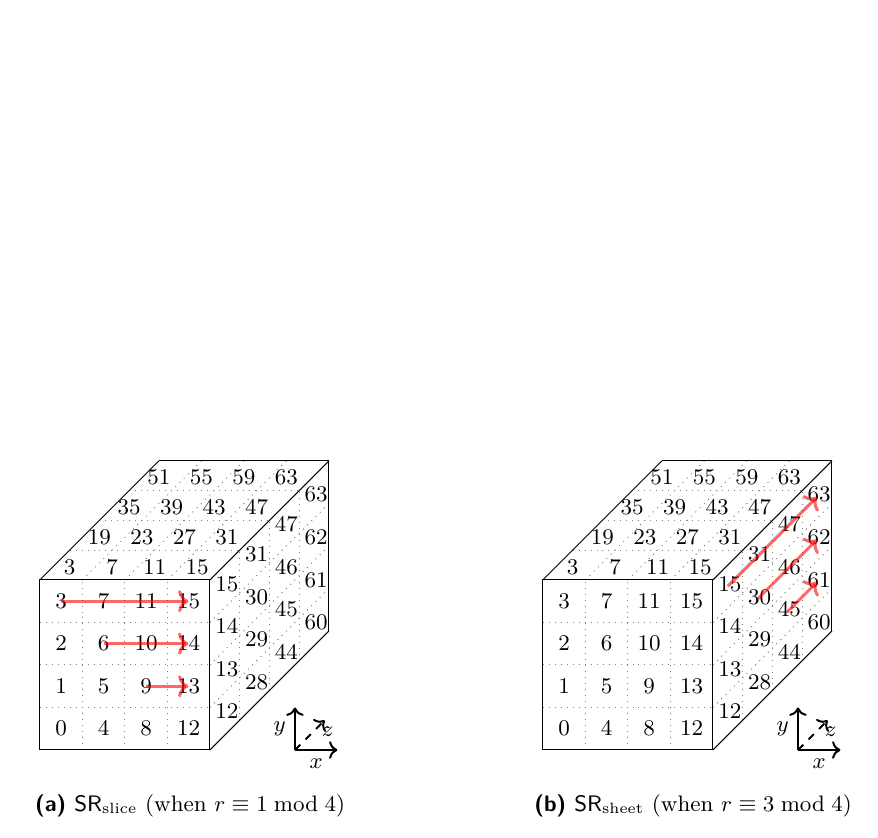
Figure 5: Representation of the SR 𝑟 operations on the